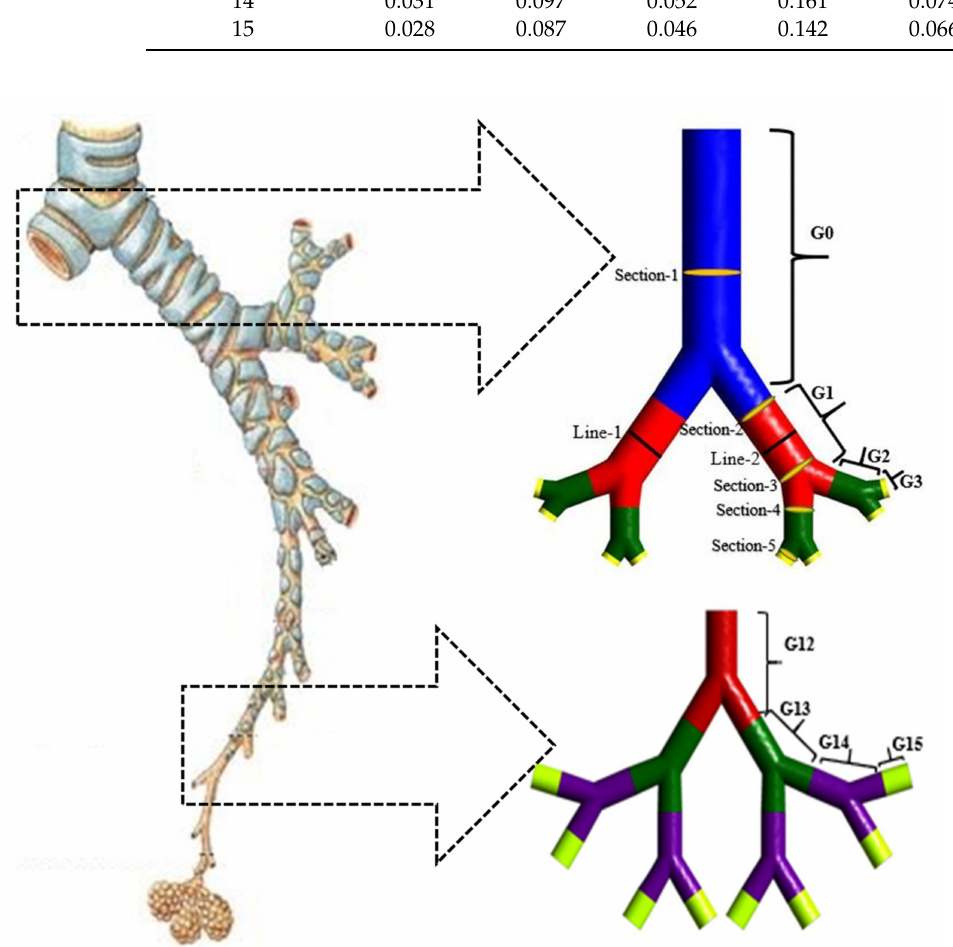
Figure 1. Symmetric models [11] (right) were used in this study to represent the human respiratory system provided by Zhang, et al. [28] (Permission has been taken to use the left figure). The details of the geometric parameters of the lung airways are presented in Table